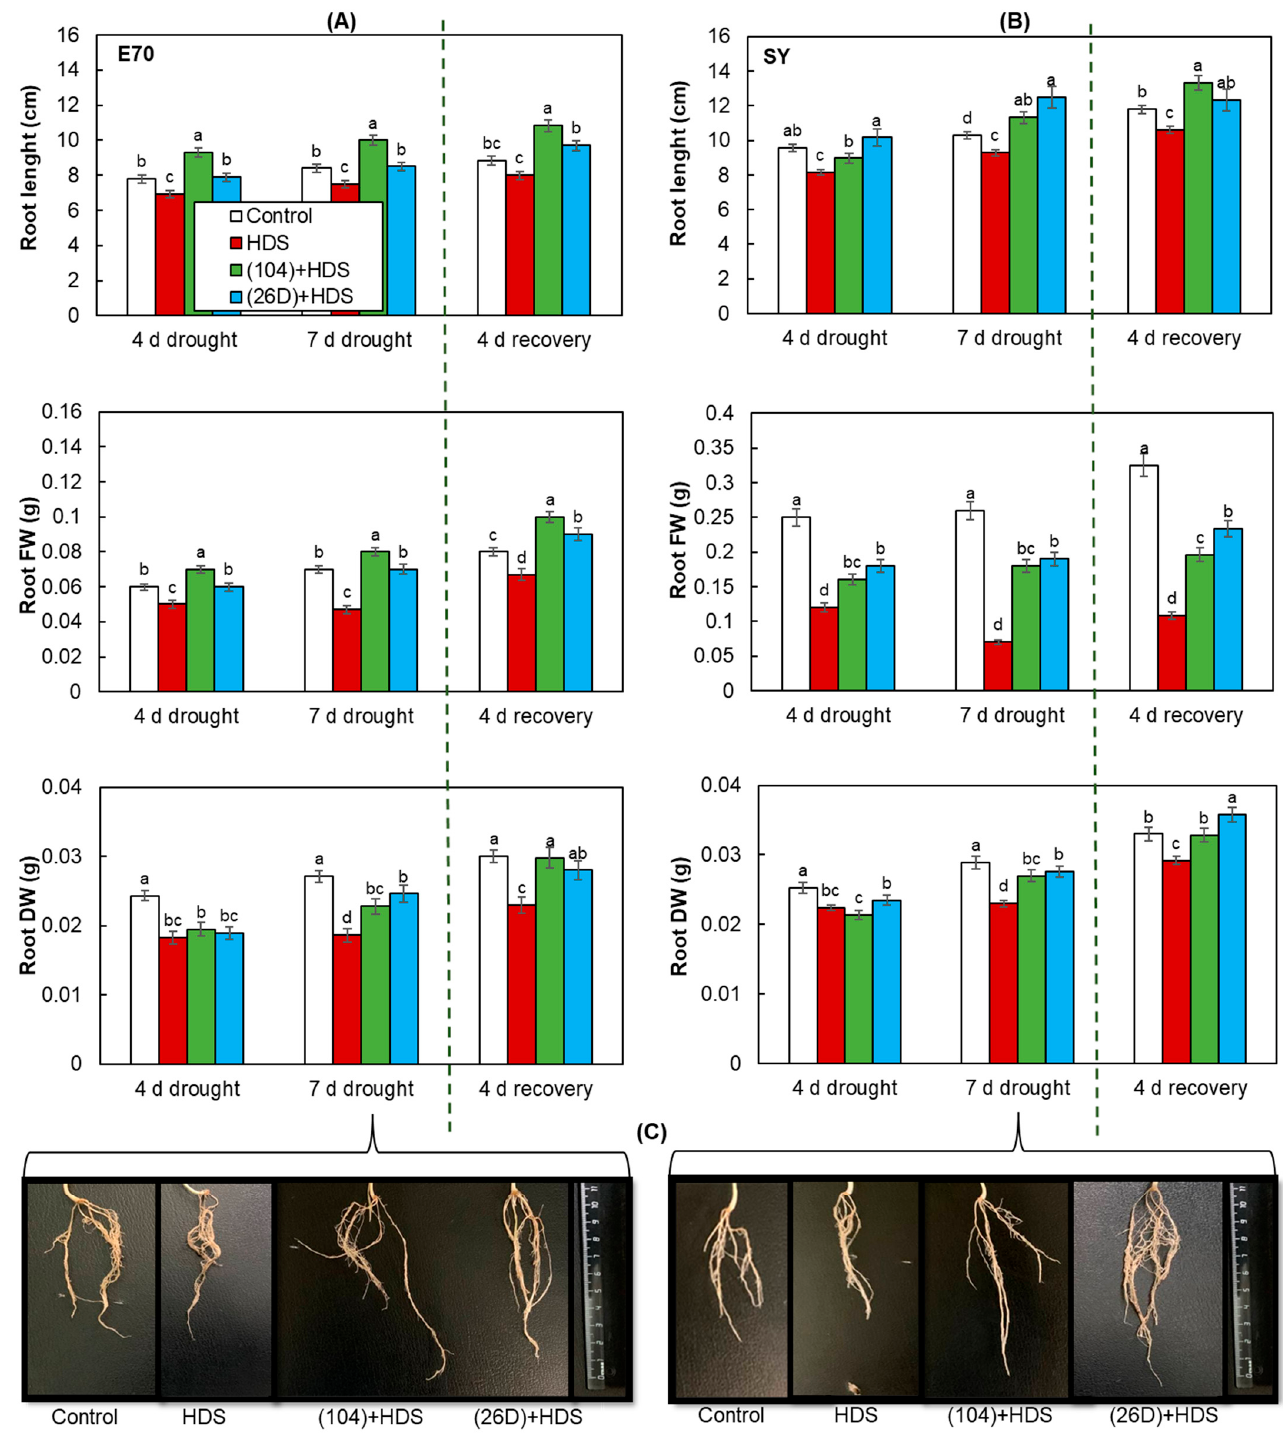
Figure 4. Influence of B. subtilis 104 and 26D on root growth (length, fresh, and dry weights) of spring wheat varieties E70 ( A ) and SY ( B ) under combined herbicide + drought stress (HDS) and the post-stress period (4 d recovery) after the resumption of normal watering; ( C ) visual appearance of wheat roots inoculated with bacterial strains (104, 26D) and after herbicide was sprayed and exposed to drought for 7 days. Error bars in fi gures represent standard errors (±SE) of the means in triplicate. Growth parameters were measured using 25 plants from each replicate. Various le tt ers show a signi fi cant di ff erence between the averages of di ff erent groups at p < 0.05. HDS—herbicide + drought stress.